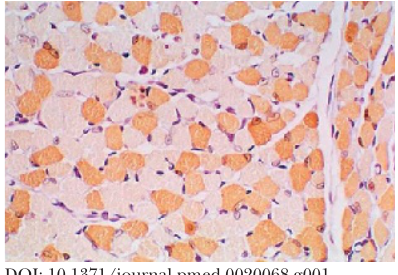
Figure 1. Specialized Myofi bers in a Mammalian Skeletal Muscle A cross-section of the gastrocnemius muscle of a mouse has been stained to detect myoglobin, which is found selectively in slow oxidative and fast oxidative myofi bers (stained brown), but not in fast glycolytic myofi bers (unstained). Human muscles exhibit a similar mosaic pattern. In response to sustained periods of motor nerve stimulation repeated daily for several weeks, the percentage of myofi bers that contain myoglobin is increased, in synchrony with an increased abundance of mitochondria and a shift of myosin subtypes from fast glycolytic to slow or fast